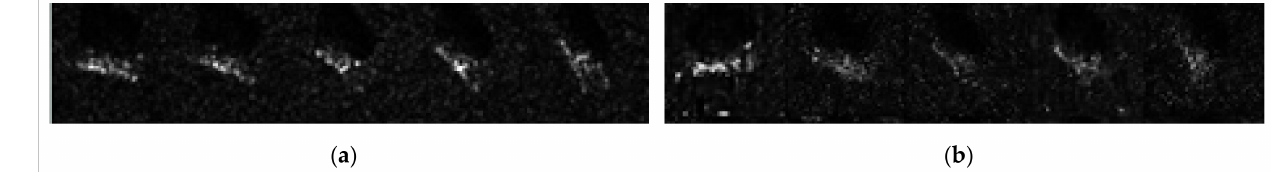
Figure 10. The comparison between examples of ( a ) 41th to 45th “BMP2”-class SAR images of D Peace “BMP2”-class SAR images of D C 17, GAN